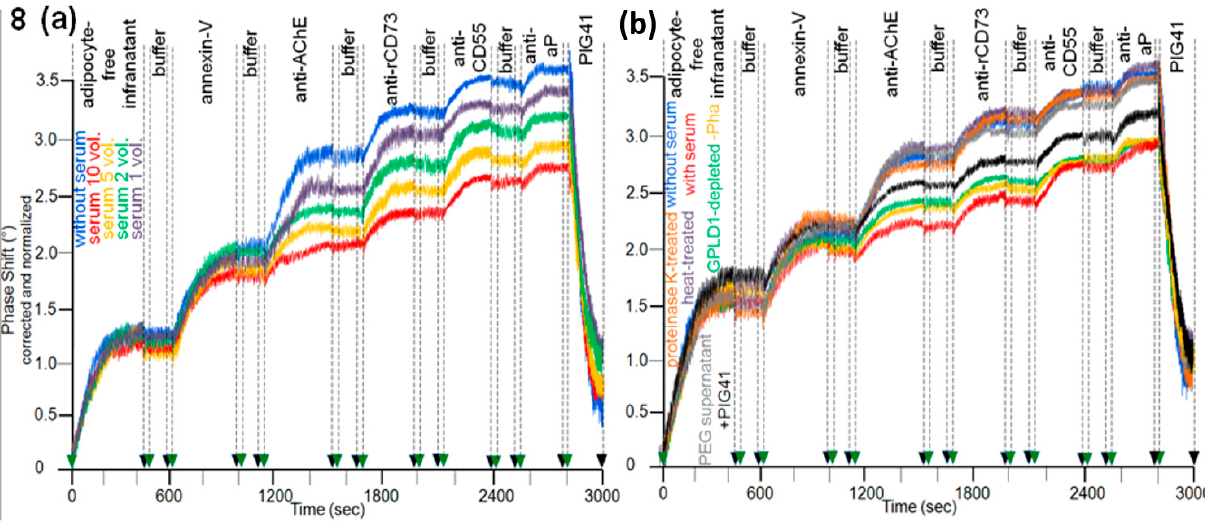
Figure 8. Effect of rat serum proteins on the translocation of bAChE from micelle-like complexes to rat adipocytes. The experiment was performed as described for Figure 7a with incubation (180 min) of isolated rat adipocytes with micelle-like bAChE complexes in the absence ( a , b , blue curves) or presence of ( a ) serum from obese ZDF rats at increasing volumes (1–10 equivalents) together with Pha or ( b ) serum from obese ZDF rats (5 volume equivalents) that had been left untreated (red curve), or either subjected to heat (10 min, 60 ◦ C; purple curve) or digested with proteinase K (brown curve), or precipitated with PEG6000 (use of supernatant; grey curve) or depleted of GPLD1 (green curve) together with Pha or untreated serum in the absence of Pha (orange curve) or untreated serum in the simultaneous presence of PIG41 and Pha (black curve). Correction and normalization of the phase shift were performed as described for Figure